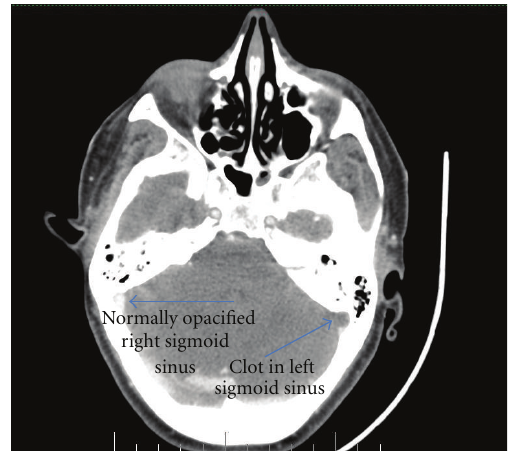
Figure 2: CT scan of the head and neck with contrast demonstrated a thrombus in the left sigmoid